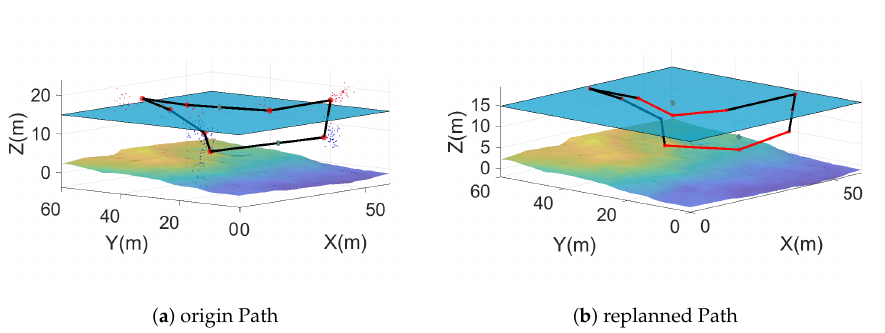
Figure 18. A comparison of an entire original path and a replanned path. Two obstacles appeared within the duration. The weighted length of the original path was 505.301308. The partly replanned path is